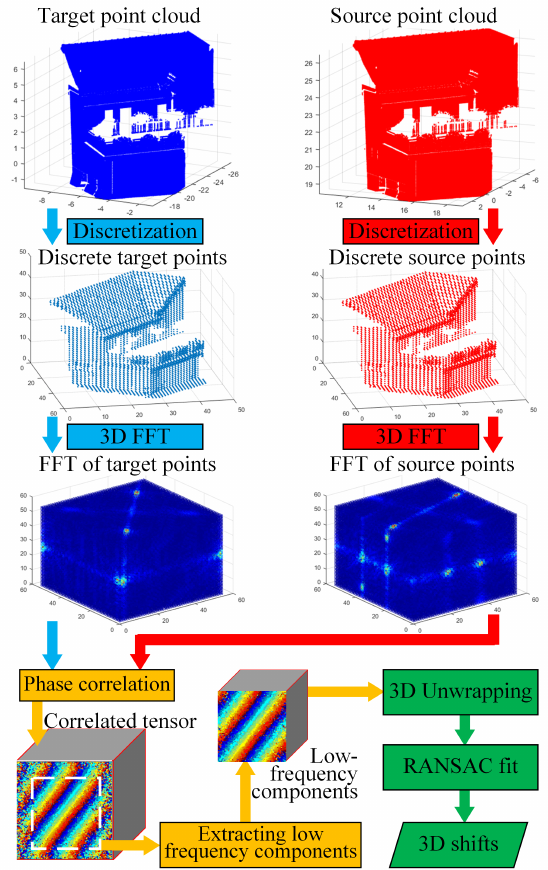
Figure 1. Workflow of the proposed 3D shifts estimation method.